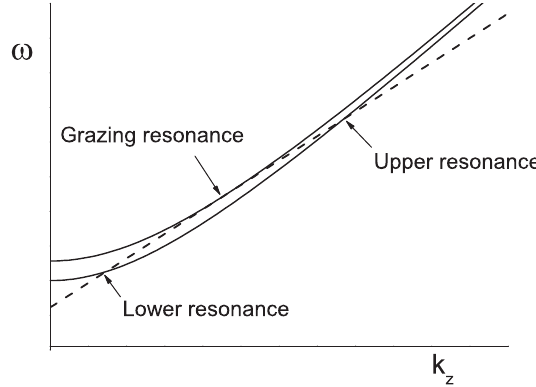
FIG. 1. Dispersion curves of the beam mode [broken line; ! ¼ ð